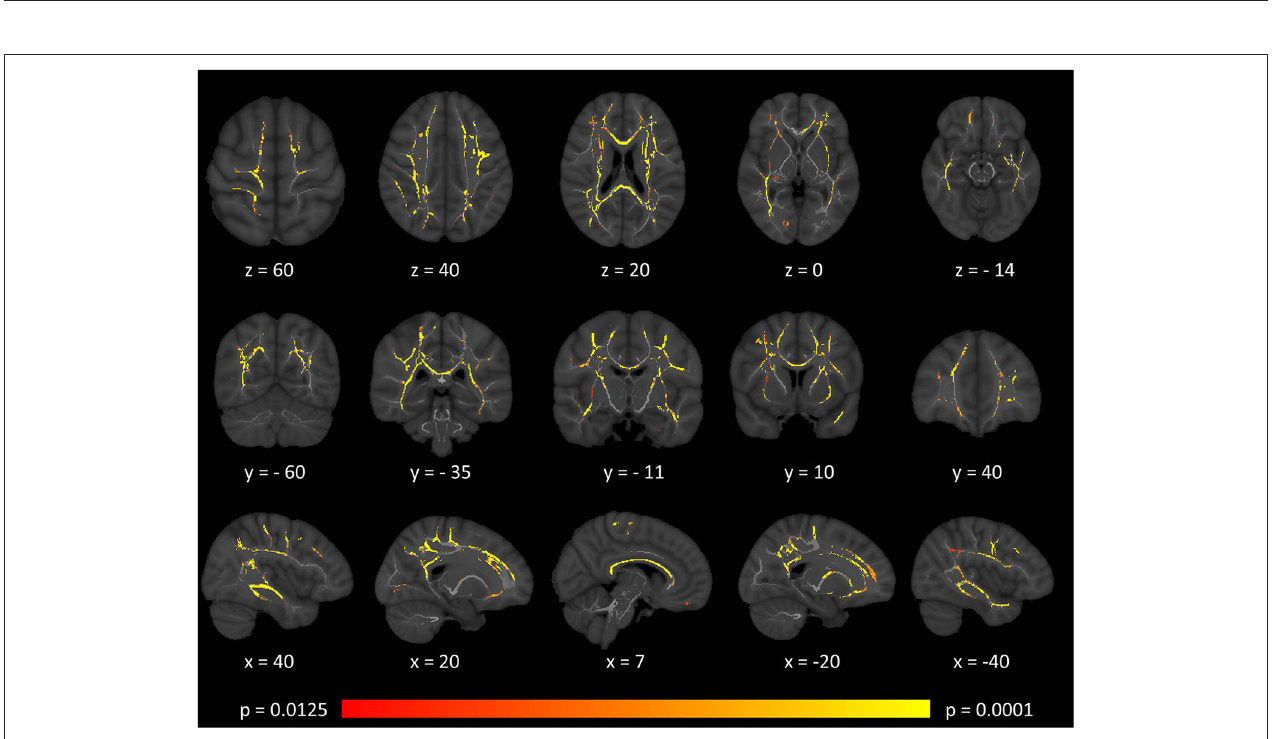
FIGURE 2 | Patterns of increased axial diffusivity (AD) in multiple sclerosis patients with gave-evoked nystagmus compared to healthy controls at p < 0.0125 FWE adjusted for age and gender following tract-based spatial statistics. Representative axial, coronal, and sagittal views are presented with corresponding MNI